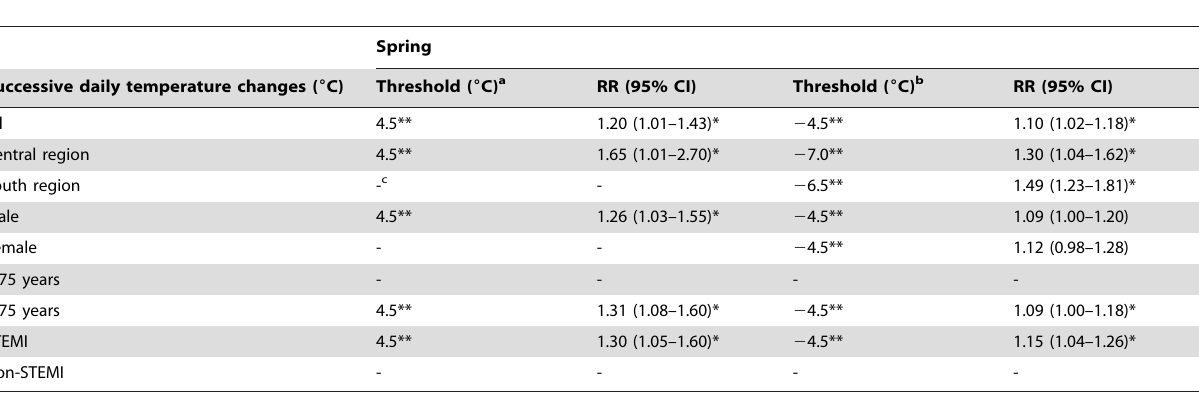
Table 5. Relative Risk of Myocardial Infarction per 1 u C Change in Successive Daily Temperature Changes by Subgroup.